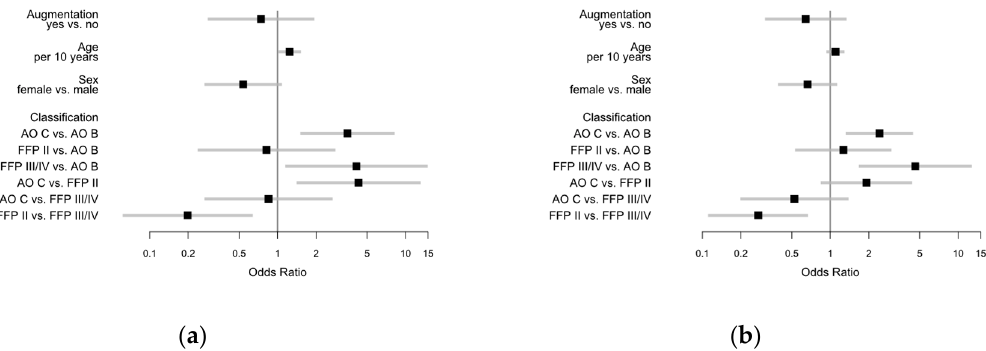
Figure 3. Odds ratios with 95% Wald confidence limits for ( a ) major complications (augmented vs. non-augmented 0.742; female vs. male: 0.538; AO C vs. AO B: 3.516; FFP II vs. AO B: 0.819; FFP III / IV vs. AO B: 4.137; AO C vs. FFP II: 4.293; AO C vs. FFP III / IV: 0.850; FFP II vs. FFP III / IV: 0.198) and ( b ) minor complications (augmented vs. non-augmented 0.642; female vs. male: 0.665; AO C vs. AO B: 2.423; FFP II vs. AO B: 1.263; FFP III / IV vs. AO B: 4.624; AO C vs. FFP II: 1.918; AO C vs. FFP III / IV: 0.524; FFP II vs. FFP III / IV: 0.273).